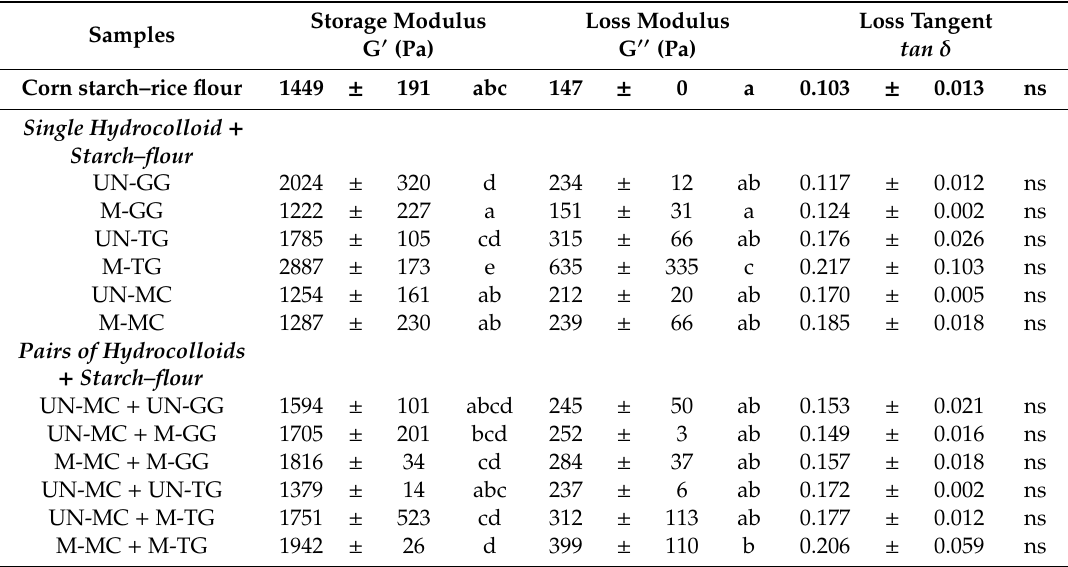
Table 3. Viscoelastic properties of corn starch–rice flour systems formulated with one or two un-milled and milled hydrocolloids. Storage Modulus Samples G (cid:48) (Pa) G (cid:48)(cid:48) (Pa) Corn starch–rice flour Single Hydrocolloid +